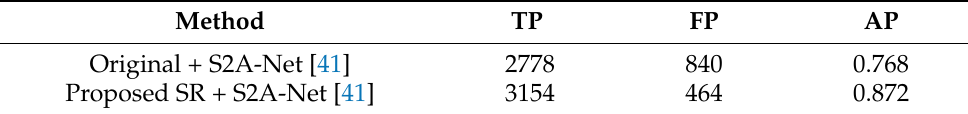
Figure 15. Object detection performance results on Hyogo, Japan: ( a ) detected small vehicles in original image ( left ) and ( b ) detected small vehicles in super resolved image ( right ). Table 3. Comparison results for original image and scaled image with scale factor 2 using proposed SR method for small vehicle detection using